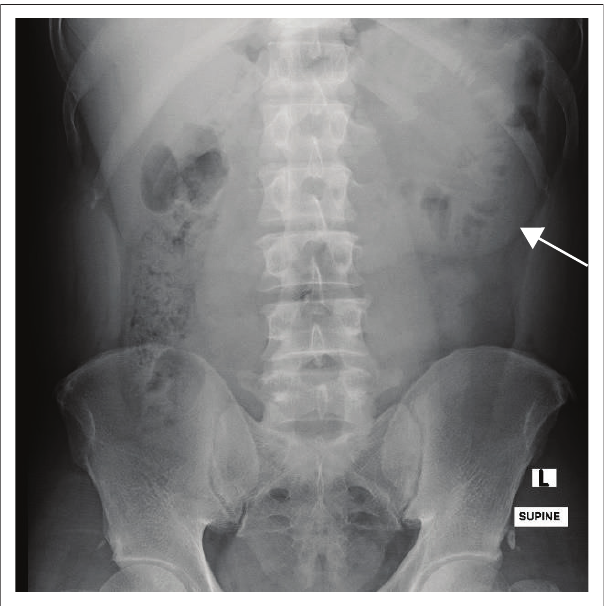
Source : Image utilised from the picture archiving and communication system (PACS) of Jackpersad and Partners Inc. FIGURE 1 : Supine anterior–posterior radiograph of the abdomen, demonstrating a well-circumscribed mass (arrow) projected in the left upper quadrant of the abdomen, representing the left paraduodenal hernia.